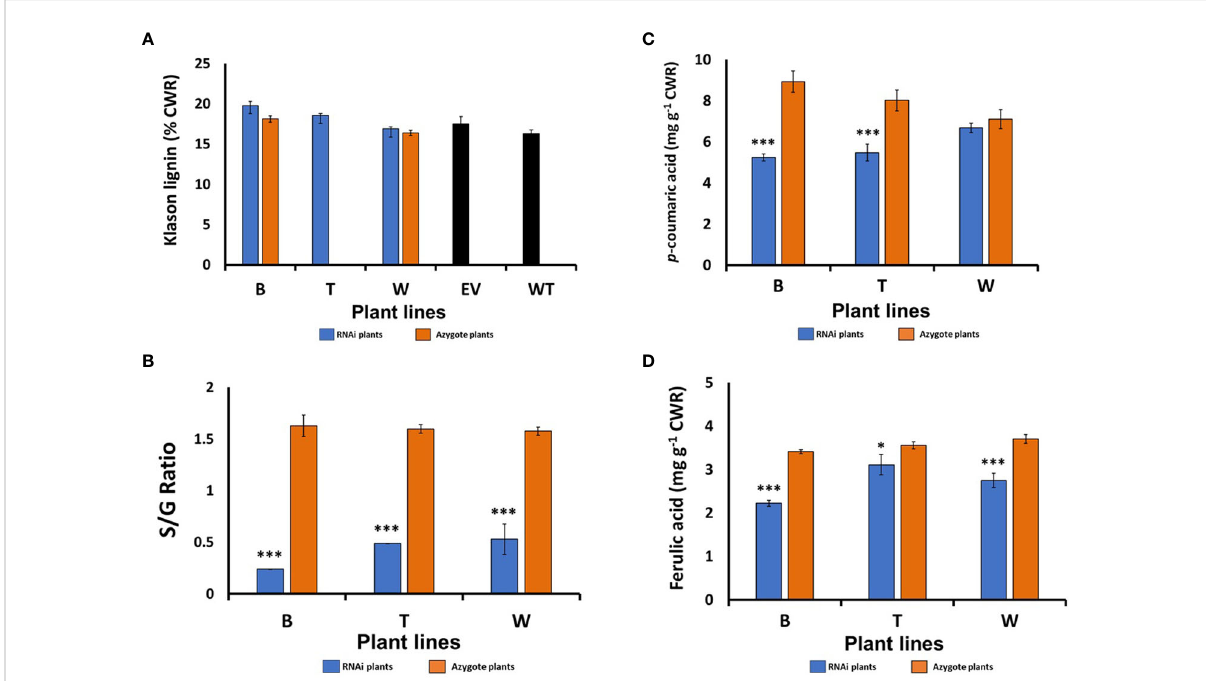
FIGURE 2 Cell wall compositional analysis of the senesced barley straw from the T2 generation HvF5H1- RNAi lines and controls: (A) Klason lignin content, (B) S/G ratio, (C) Ester-linked p ‐ coumaric acid ( p CA), (D) ester-linked ferulic acid (FA), as measured by mild alkaline hydrolysis. Lines marked with * & *** are signi fi cantly different from their controls which were the respective azygote plants in the case of lines B and W; for line T where no azygous controls were available, comparisons were made with empty vector (EV) plants for Klason lignin or with all azygote plants for S/G ratio and ester-linked p CA and FA, Student ’ s t ‐ test P <0.05 and P <0.001, respectively for * and ***. The error bars represent standard errors between 3-7 biological replicates (i.e. independent plants). B, T, and W; RNAi lines; EV: Empty vector; WT: wild